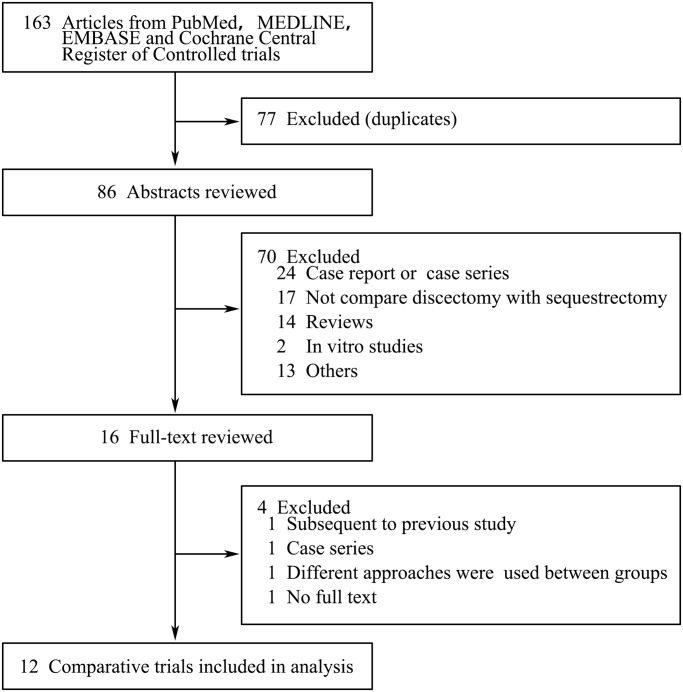
Flow diagram of the literature search.